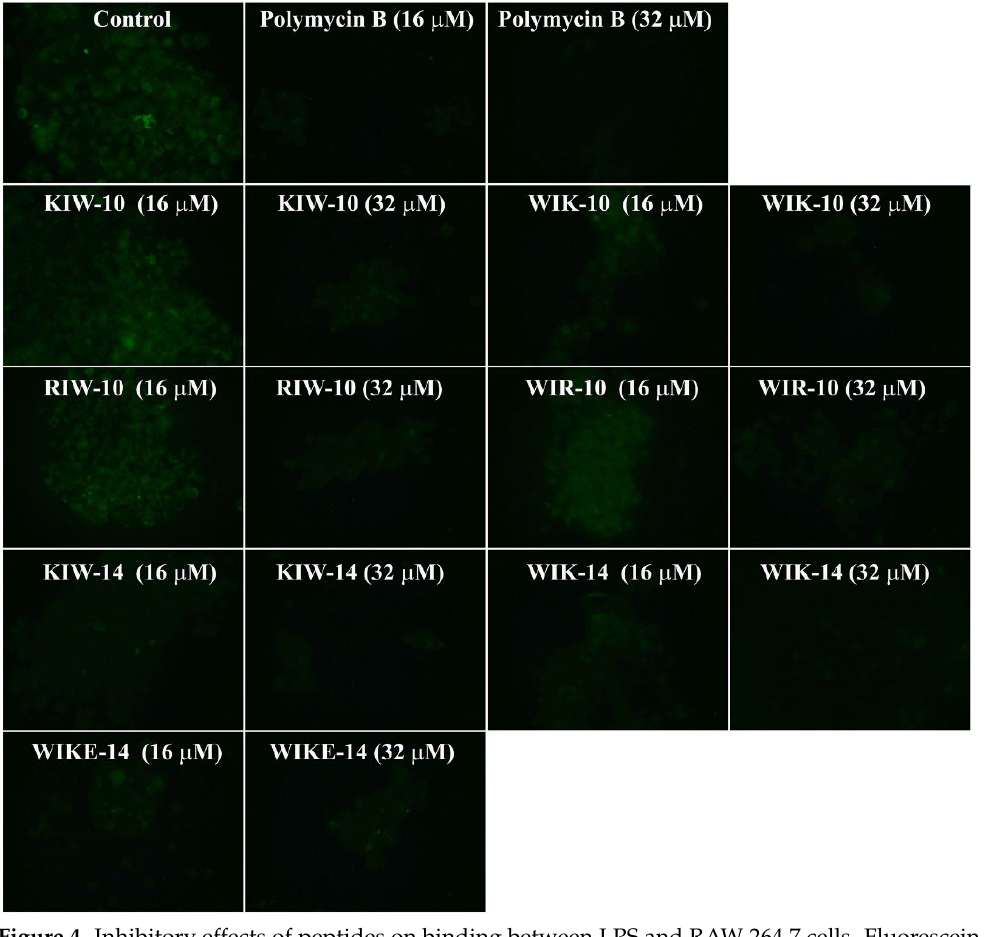
Figure 4. Inhibitory effects of peptides on binding between LPS and RAW 264.7 cells. Fluorescein isothiocyanate-labeled LPS and peptides were incubated for 12 h with RAW 264.7 cells, and cells were washed with PBS, followed by observation using fluorescence microscopy.